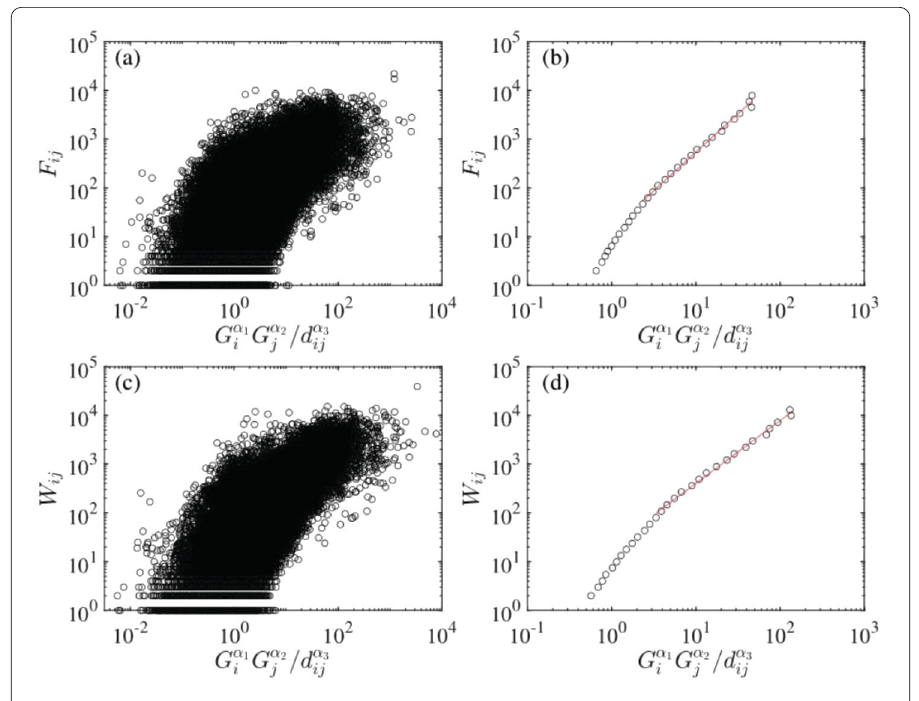
Figure 13 Testing the modified gravity law with GDP for the directed and undirected freight highway transportation networks constructed over five months. ( a ) Scatter plot of F ij with respect to G α 1 i G α 2 j / d α 3 ij for the directed network. ( b ) Binning plot of F ij with respect to G α 1 plot of W ij with respect to G α 1 G α 1 i G α 2 j / d α 3 ij for the undirected